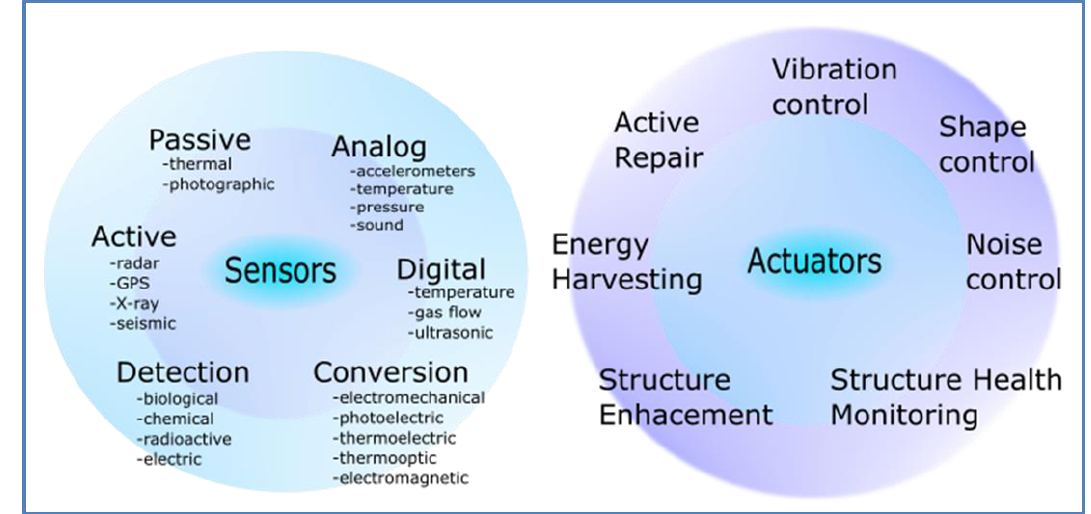
Figure 1. Applications of actuators and sensors.